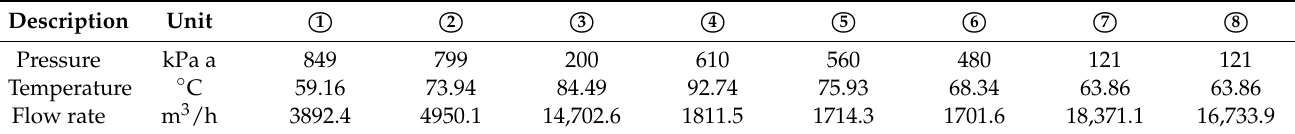
Table 3. Heat and mass